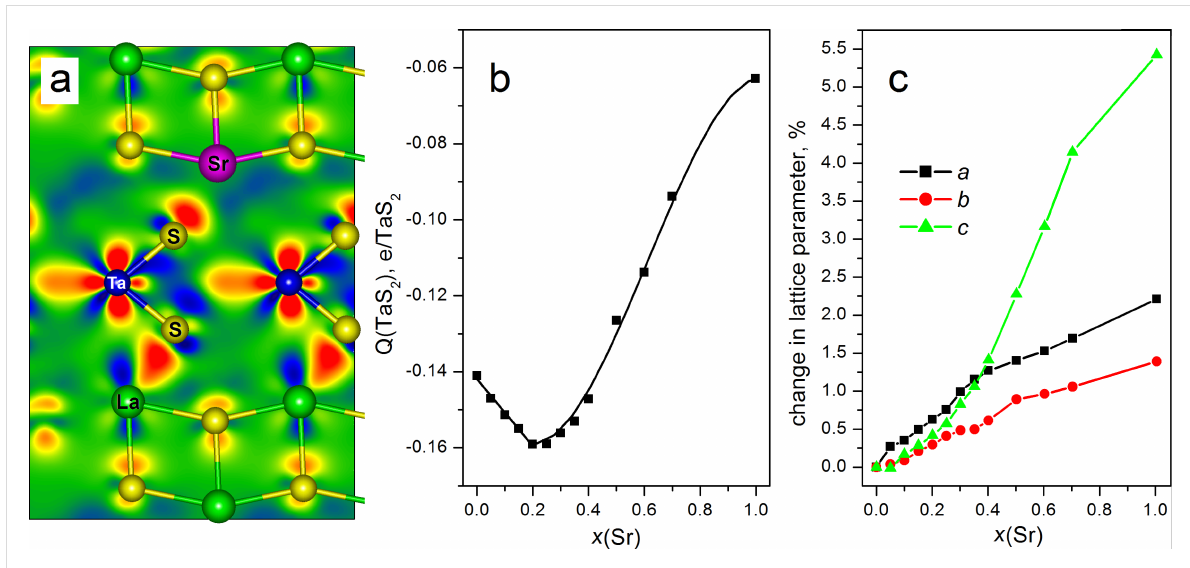
Figure 10: DFT calculations presenting the peculiarities of the chemical bonding within the Sr x La 1 − x S–TaS 2 misfits, as a function of the Sr content. (a) Charge redistribution map at the interface formed between the Sr 0.05 La 0.95 S slab and single TaS 2 layer. Red and blue colors on the map corre- spond to an increase and decrease of electron density on 0.05 e/Å 3 , respectively, and the green color corresponds to no change when compared to isolated layers. (b) The value of charge transfer ( Q ) from the Sr x La 1 − x S to TaS 2 layer, and (c) modulation of the lattice parameters ( a , b , c ) with ascending Sr content (and reduced La